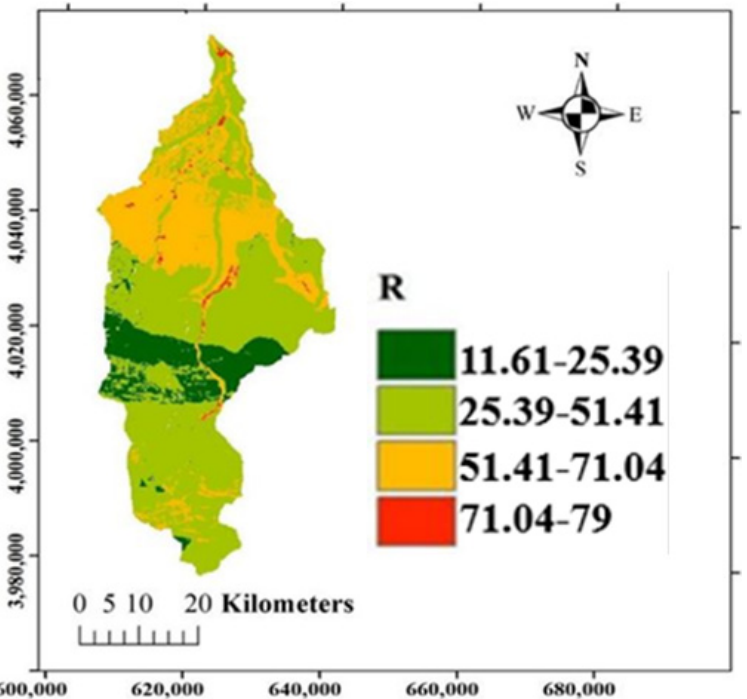
Figure 6. R parameter in the Babolroud